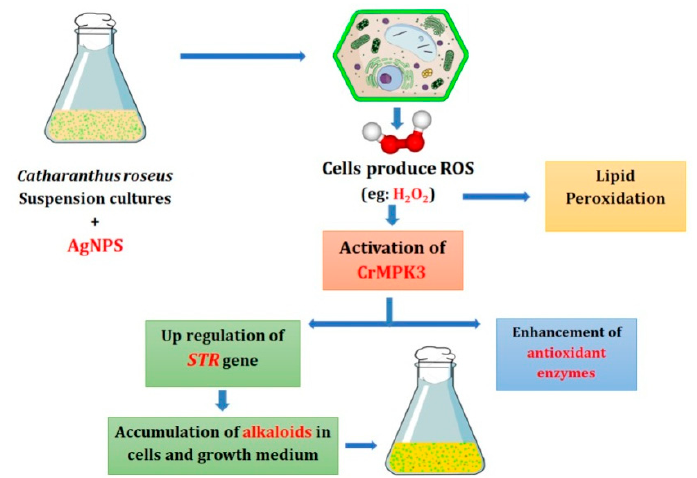
Figure 6. Summary for the action mechanism for AgNPs-mediated alkaloids biosynthesis in Catharanthus roseus.